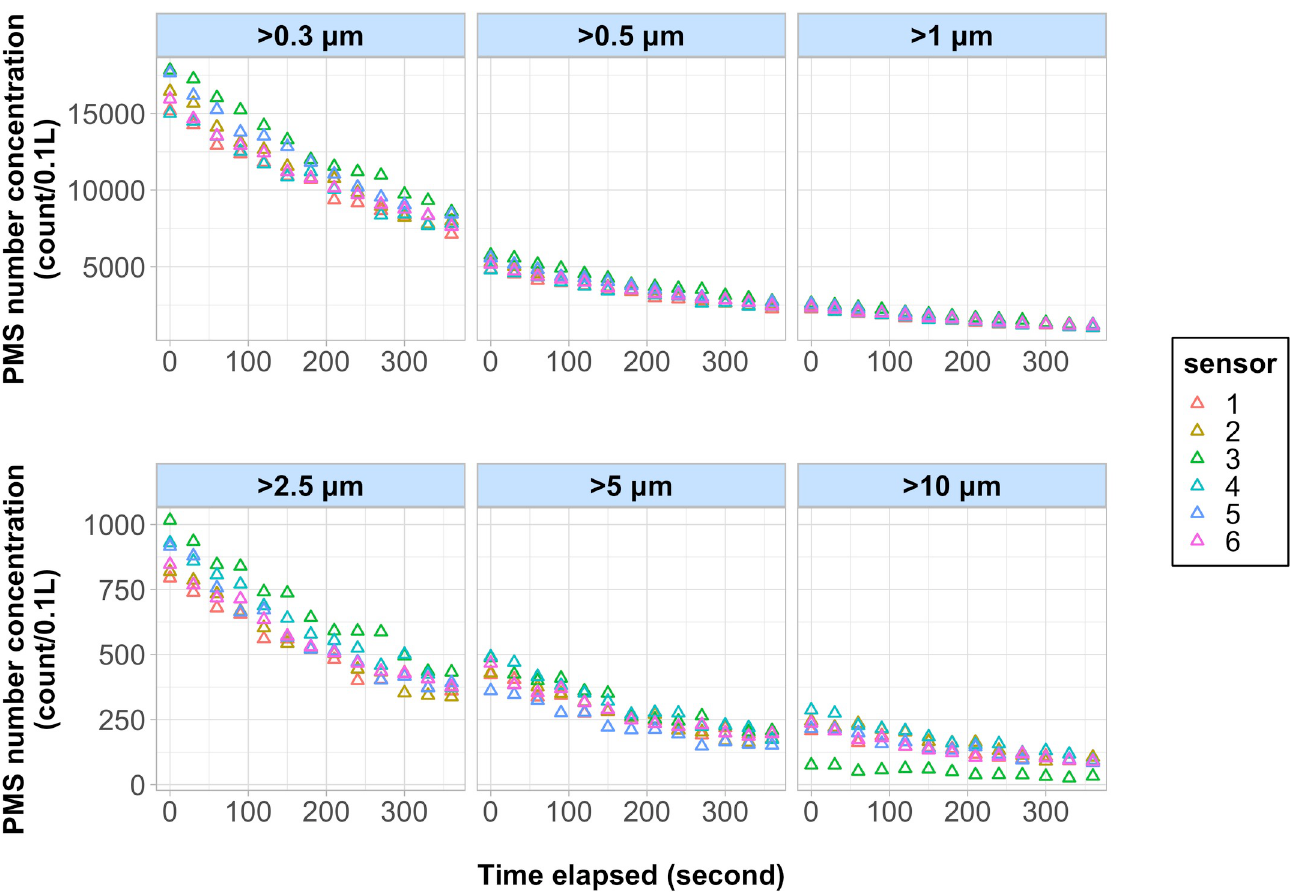
Fig 3. Time-series plots of the uncalibrated, 1-second number concentration measurement from the six PMS sensors are presented. The experiments were conducted under 30% relative humidity with W210 aerosols. linear models adjusted for relative humidity, particle density, and CRI were evaluated (S1 Table). For calibration of mass concentration, models including quadratic terms of the PMS measurement were evaluated (S1 Table). Since the test temperature variations were within ± 2˚C, the temperature was not included as a variable in the models. Based on a priori assump- tion that the PMS particle count and mass indices should be zero when the APS count is zero, the intercept ( β ) of the models was set to zero. The number of terms included in the optimal 0 calibration model for each size bin was determined based on the Bayesian Information Crite- rion (BIC). The models with lower BIC were chosen as the optimal models. After identifying the optimal models using BIC and estimating model coefficients, the model was then applied to the pre-calibrated 1-minute PMS measurement to produce the post-calibrated concentra- tions for model evaluation. Calibration performance was assessed using the normalized mean absolute error (NMAE), which was calculated using the following equation [53]: